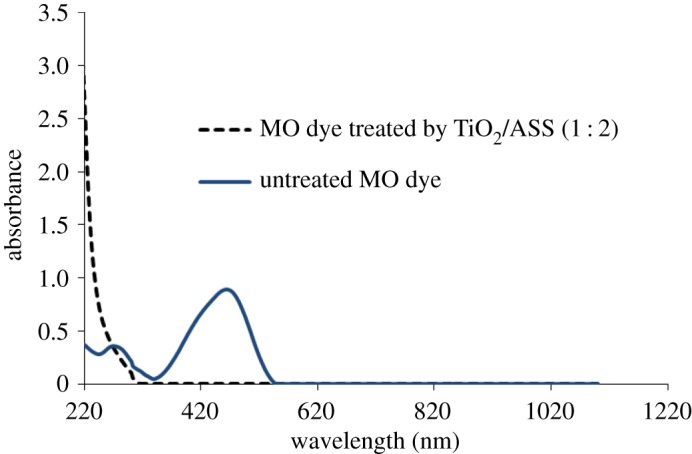
UV-vis spectra of untreated MO solution and treated MO solution by TiO2/ASS (1 : 2).